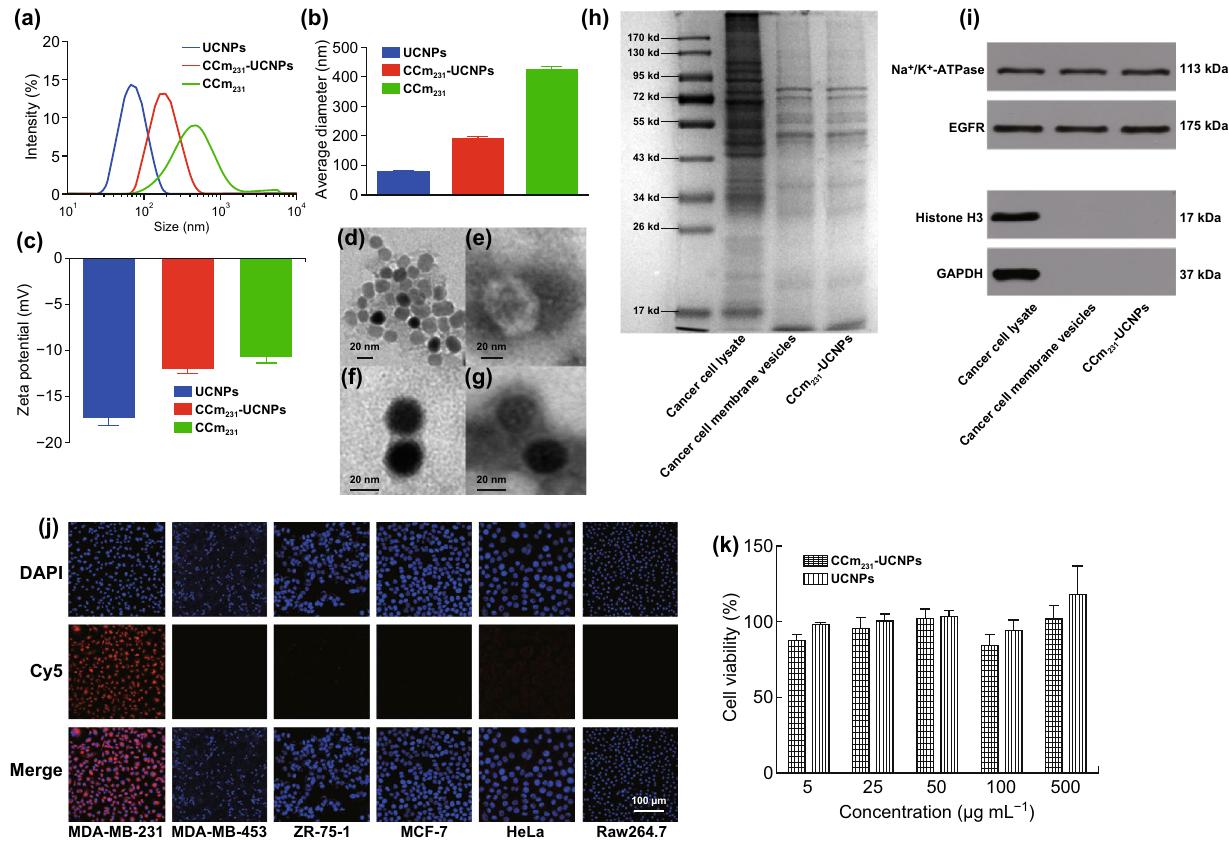
Fig. 1 Physicochemical characterization of CCm 231 ‑UCNPs. a Size intensity curves, b hydrodynamic size, and c zeta potential of UCNPs, CCm 231 ‑UCNPs, and CCm 231 measured by dynamic light scattering (DLS). TEM images of d UCNPs, e CCm 231 , and f , g CCm 231 ‑UCNPs. The TEM samples were negatively stained with phosphotungstic acid. The scale bars = 20 nm. h SDS‑PAGE protein analysis of MDA‑MB‑231 can‑ cer cell lysate, cancer cell membrane vesicles, and CCm 231 ‑UCNPs. Samples were run at equal protein concentration and stained with Coomas‑ sie Blue. i Western blotting analysis. Samples were run at equal protein concentration and immunostained against membrane markers including Na + /K + ‑ATPase, EGFR, histone H3 (a nuclear marker), and glyceraldehyde 3‑phosphate dehydrogenase (a cytosolic marker). In vitro homolo‑ gous‑targeting ability and cytotoxicity of CCm 231 ‑UCNPs. j Confocal laser scanning microscopy (CLSM) images of various cells after incuba‑ tion with CCm 231 ‑UCNPs. The scale bars = 100 μm. k Survival of MDA‑MB‑231 cells treated with different concentrations of CCm 231 ‑UCNPs and UCNPs. The data points represent mean ± SD ( n =